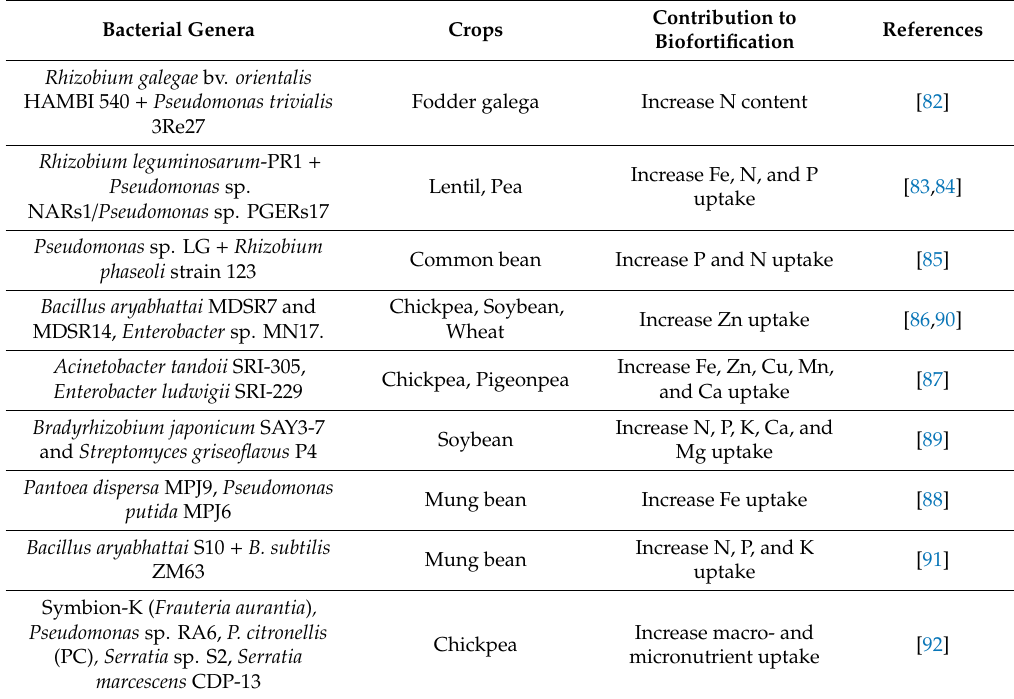
Table 2. Summary of studies showing the potential of some bacterial genera for legume